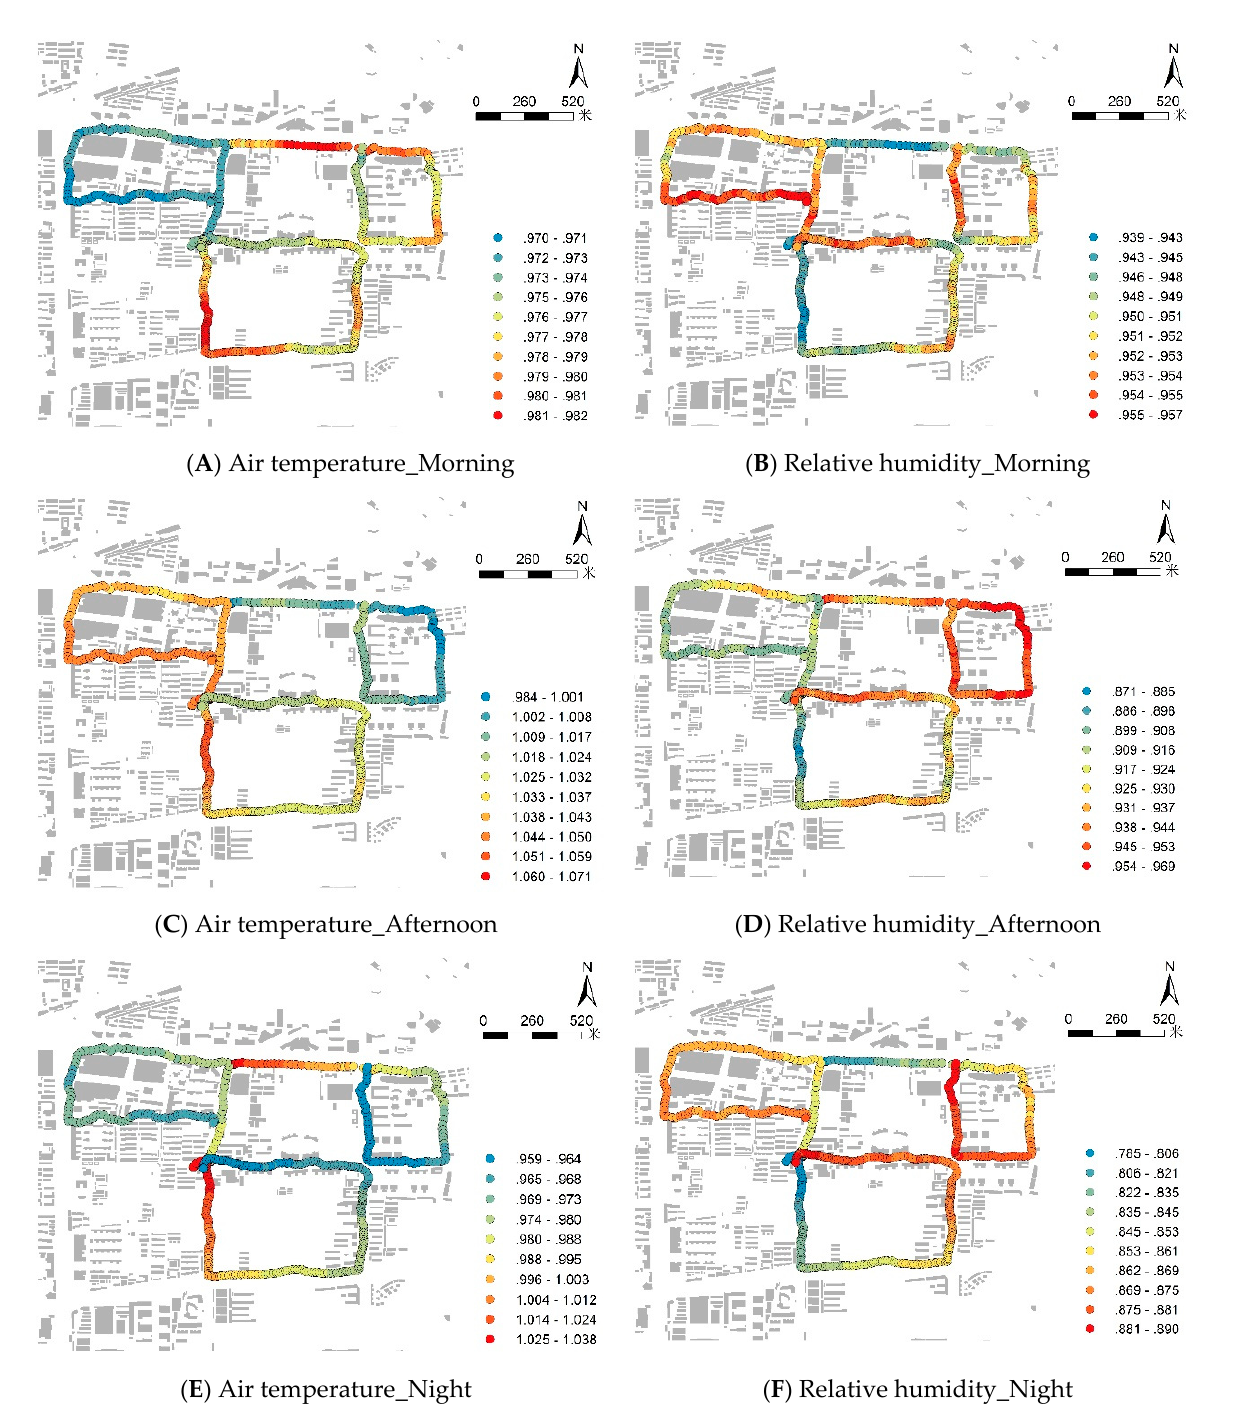
Figure 7. Distributions of four-day average air temperature ratio and relative humidity ratio of the Yanzhuang residential district. Table 5. Pearson’s correlation coefficients between air temperatures (relative humidity) at different times of the day for the commercial district ( n = 27).